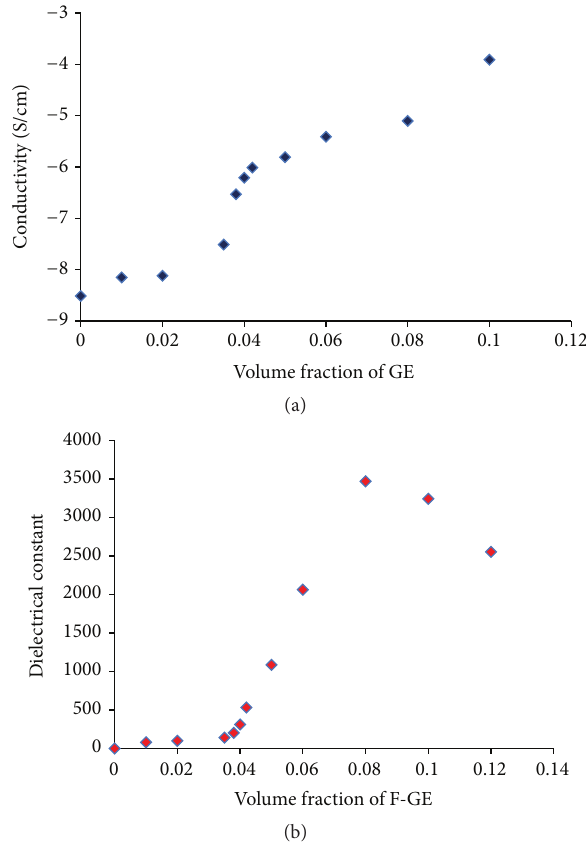
Figure 7: Dependence of (a) the electrical conductivity and (b) dielectric constant of GE-CH-PMNA composite on the volume fraction of